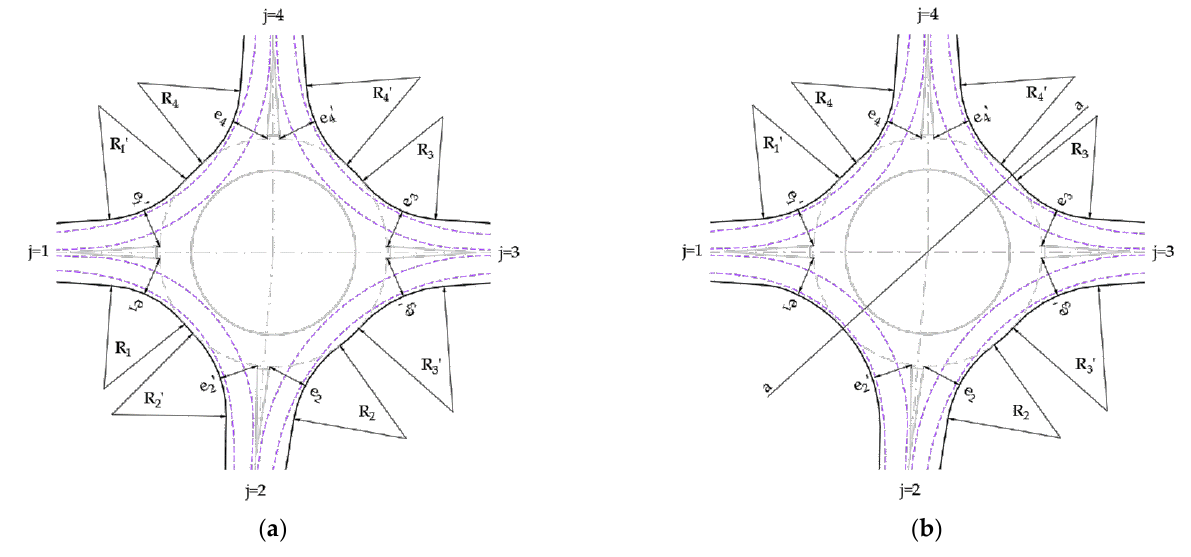
Figure 2. Roadway right edge design based on the trajectory of the vehicle’s right-turn movement: ( a ) defined by entry radius and exit radius; ( b ) defined by the trajectory of the design vehicle.